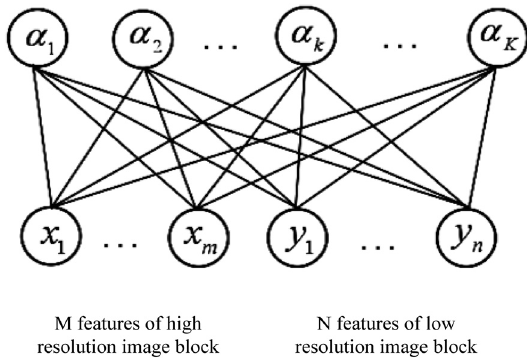
Figure 4: RBM - based joint dictionary learning network